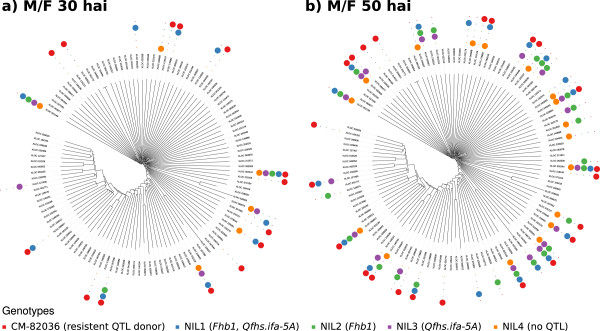
Regulation of WRKY genes at different time points. Dendrograms display differential expression of WRKY genes (a) 30 and (b) 50 hours after inoculation (hai) with F. graminearum spores. Genes that are significantly changed for the given genetic background (NIL1-NIL4, CM-82036) in response to F. graminearum are indicated in the respective color. Note that the clades within dendrogram do not necessarily reflect groups or families of related genes, but are only used for presentation purposes.